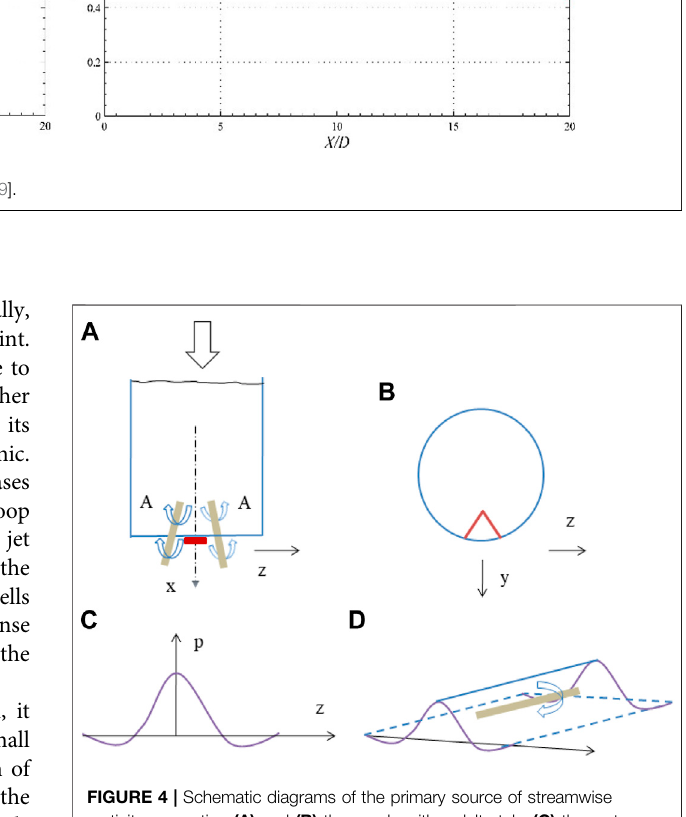
FIGURE 4 | Schematic diagrams of the primary source of streamwise vorticity generation (A) and (B) the nozzle with a delta tab; (C) the vortex fi lamentisemergingfromthesidesofatab; (D) pressuredistributioninfrontof the tab